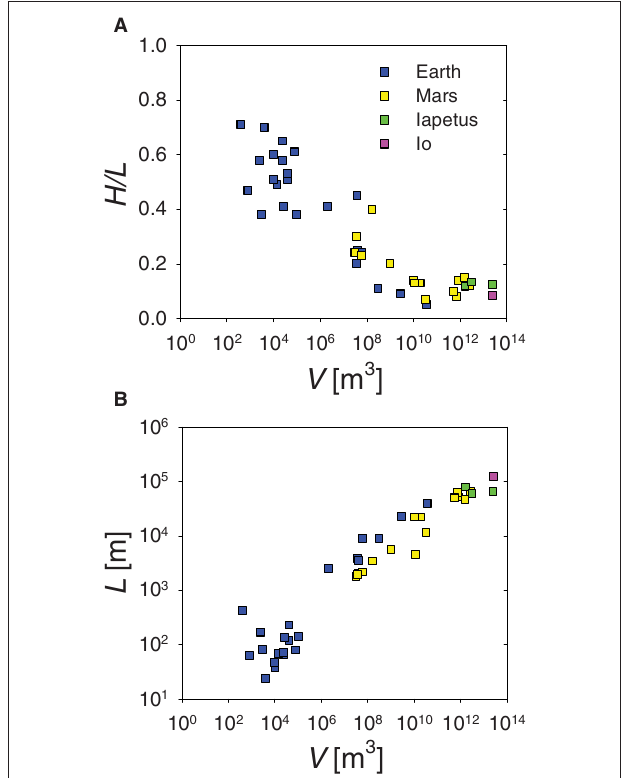
FIGURE 2 | (A) Heim’s ratio H / L for a collection of landslides from the Earth ( g 9.81ms − 2 ), Mars ( g 3.73ms − 2 ), Iapetus ( g 0.223ms − 2 ), and Io = = = ( g 1.796ms − 2 ), taken from Lucas et al. [2]. Note that Heim’s ratio decreases = with landslide volume to a value as low as 0.1 , i.e., considerably lower than ≈ friction coefficient of common rocks or soils. (B) Runout as a function of landslide volume for the same collection of